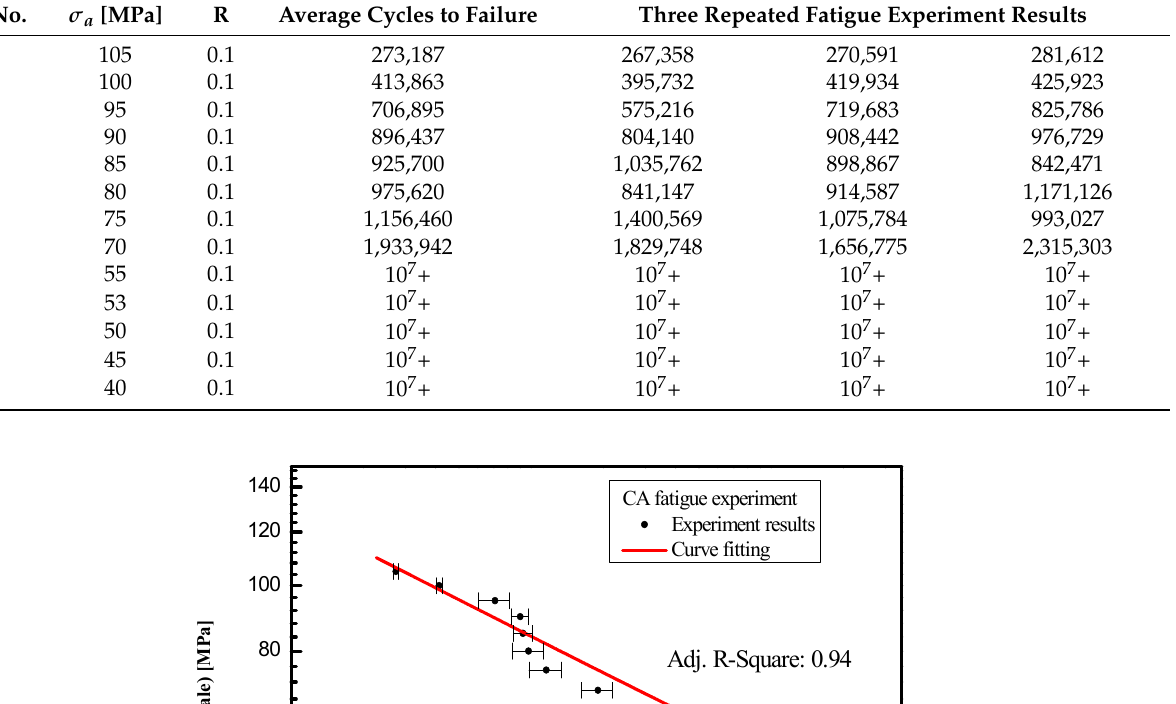
Table 4. CA loading tests of designed T-type specimens.